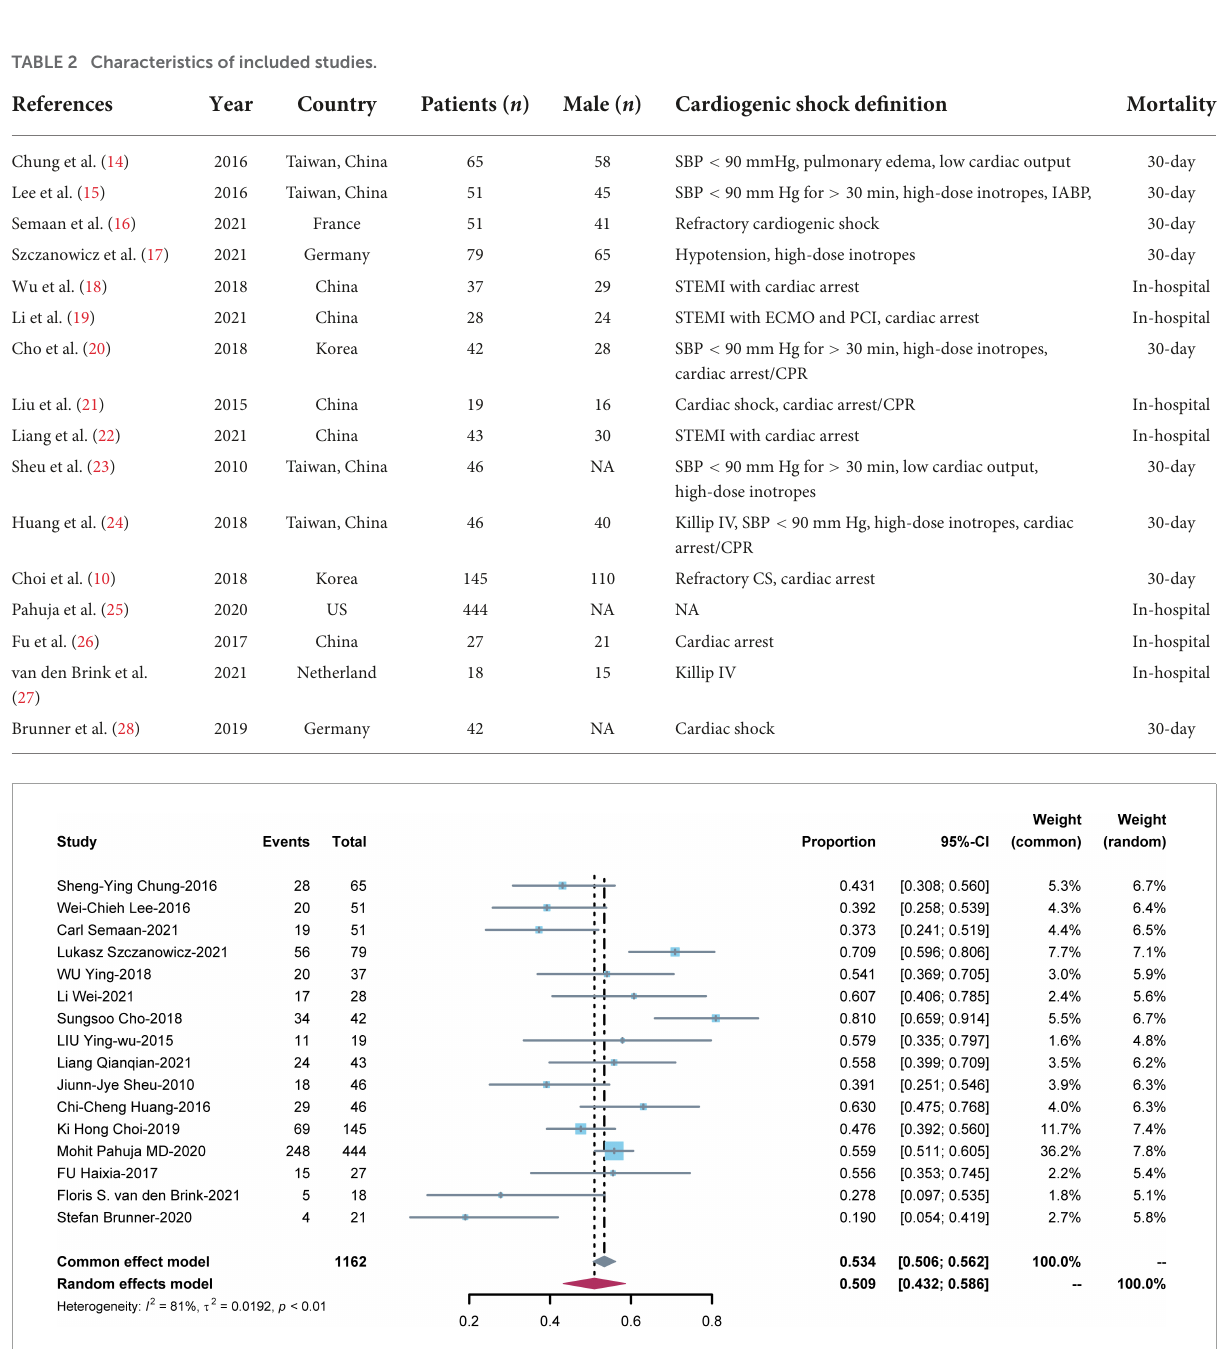
pooled estimate of the OR was 0.509 [95% CI: (0.432, 0.586)] in a random effects model with significant heterogeneity (I 2 = 81%, P < 0.01). In sensitivity analysis, the overall effect size was not substantially affected after removing each study in turn ( Supplementary Figure 1